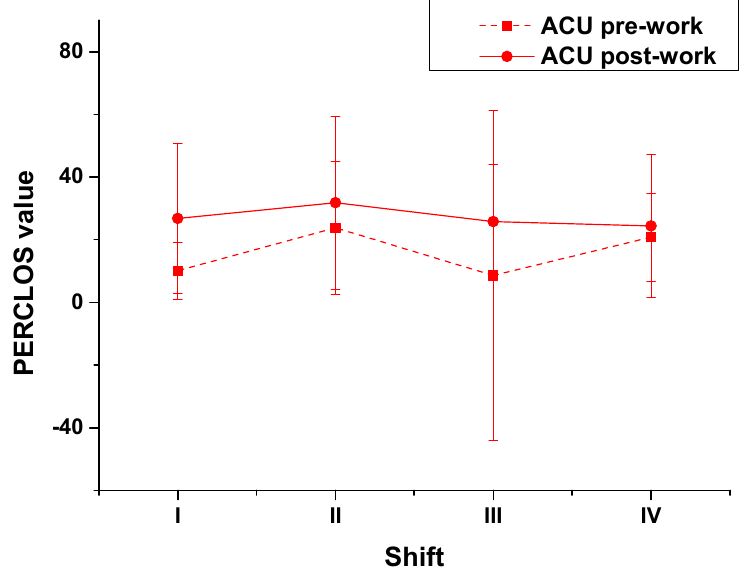
Figure 8. PERCLOS values of ATCOs at the ACU by shifts.